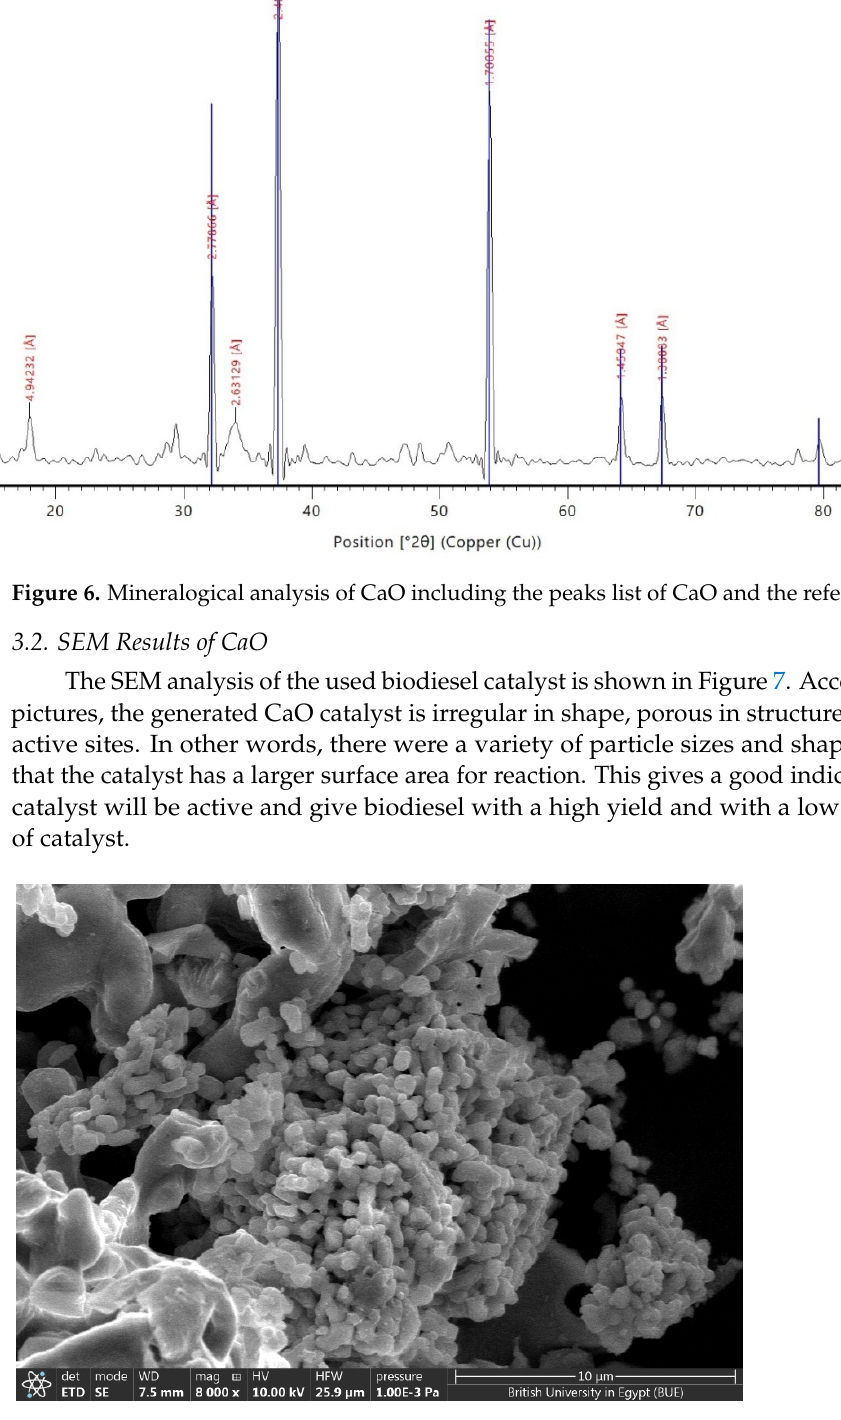
Figure 7. SEM of biodiesel catalyst (CaO) .